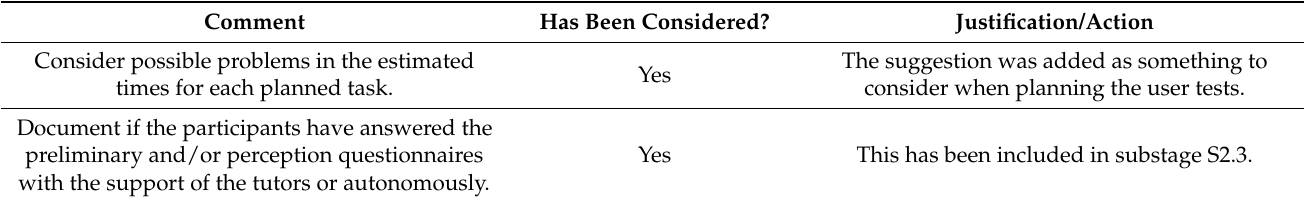
Table 4. Results of question O3.